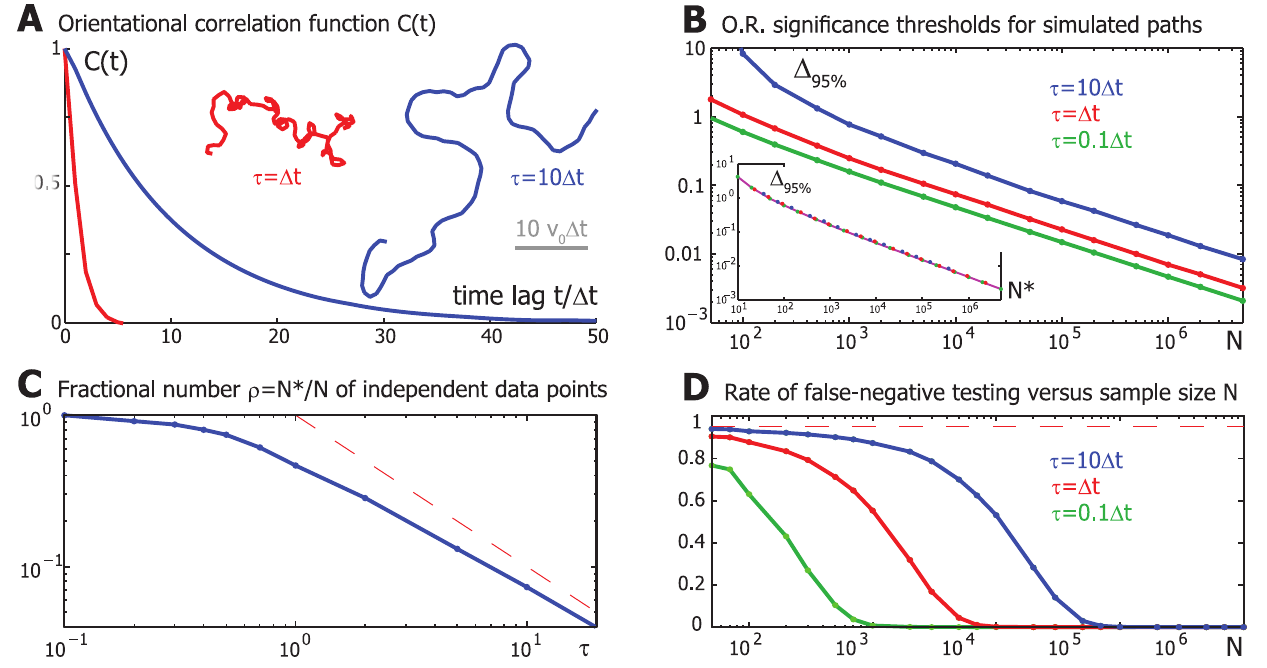
Figure 2. Effect of tunable directional persistence on tests of motion bias for a simple mathematical model of stochastic swimming paths. A. Orientational correlation function C ( t ) of the (frame-to-frame) swimming direction angle of simulated persistent random walks for two values of the persistence time t = D t (red) and t =10 D t (blue). Also shown are two example tracks. B. 95% percentile of the odds ratio distribution of simulated persistent random walks as a function of sample size N for different values of the persistence time t (green: t =0.1 D t , red: t = D t , blue: t =10 D t ). (For each value of t , we used simulated control data sets each comprising 10 4 persistent random walks of duration 100 D t .) Lower inset : Significance threshold D * 95% for a simulated control data set devoid of correlations as a function of test sample size N * (magenta line). The significance thresholds determined by block bootstrapping of simulated persistent random walks superpose with those for the